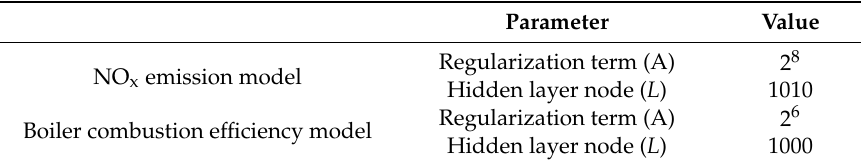
Table 1. Parameter selection of boiler combustion